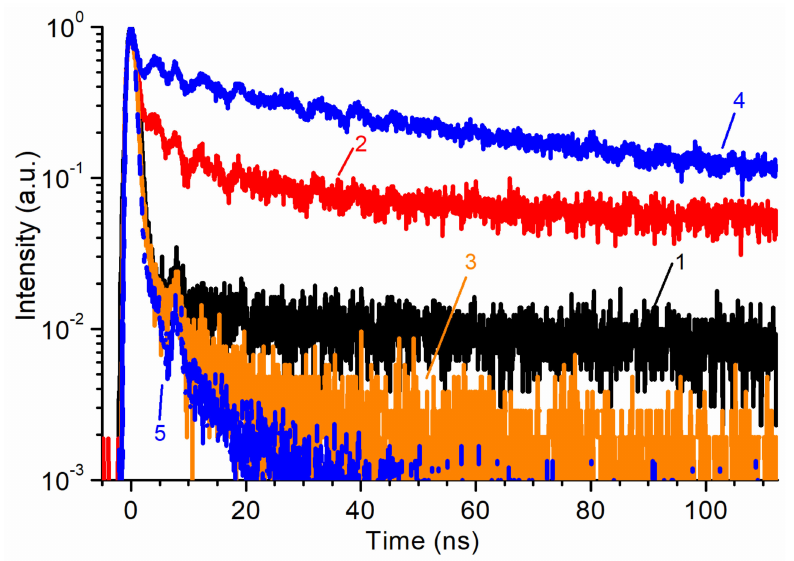
Figure 5. RL decay kinetics of studied ZnO samples: 1—whiskers; 2—whiskers annealed in air; 3—nanowalls; 4—undoped ceramics; 5—doped with 0.075 wt.% Ga